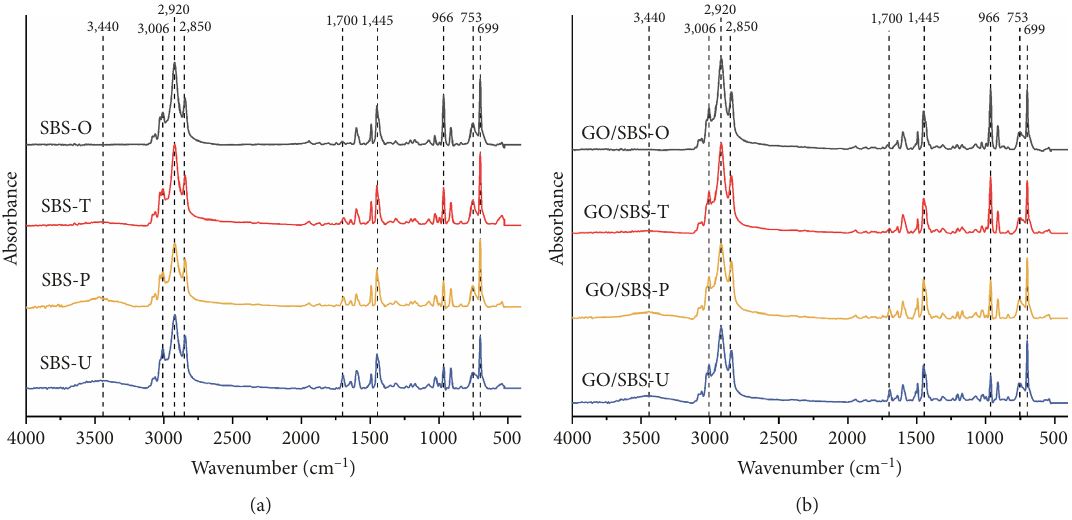
Figure 4: FTIR spectra recorded for SBS (a) and the GO/SBS composite (b) before and after